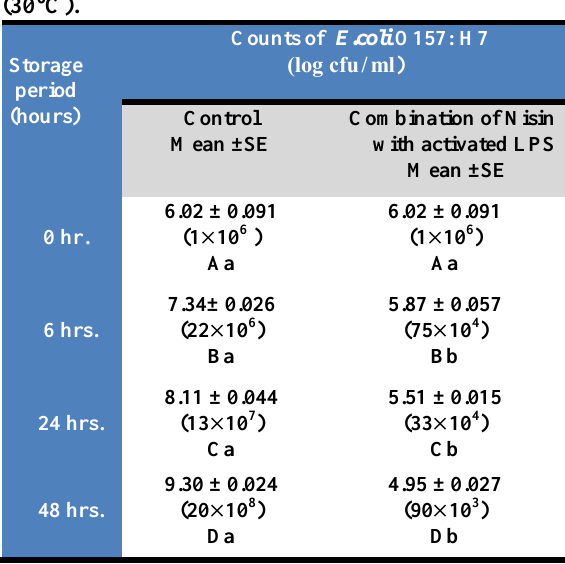
4: The effect of Nisin (50IU/ml) in combination with activated Lactoperoxidase system on the survival rate of E.coli cf ml) in pasteurized milk that stored at ambient temperature